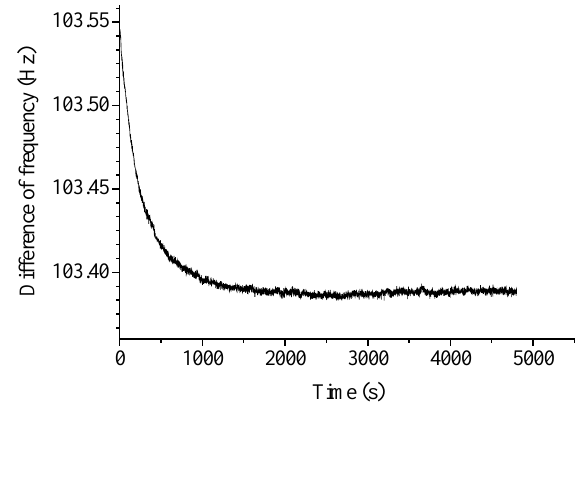
Figure 18. The bias stability measurement